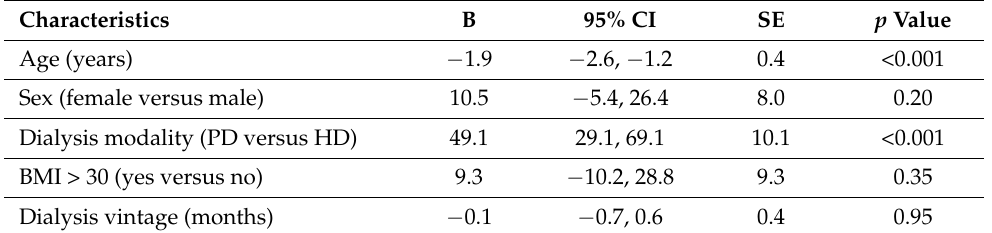
Table 2. Baseline predictors of maximum anti-S1 IgG antibody concentration in dialysis patients 3 weeks after the second